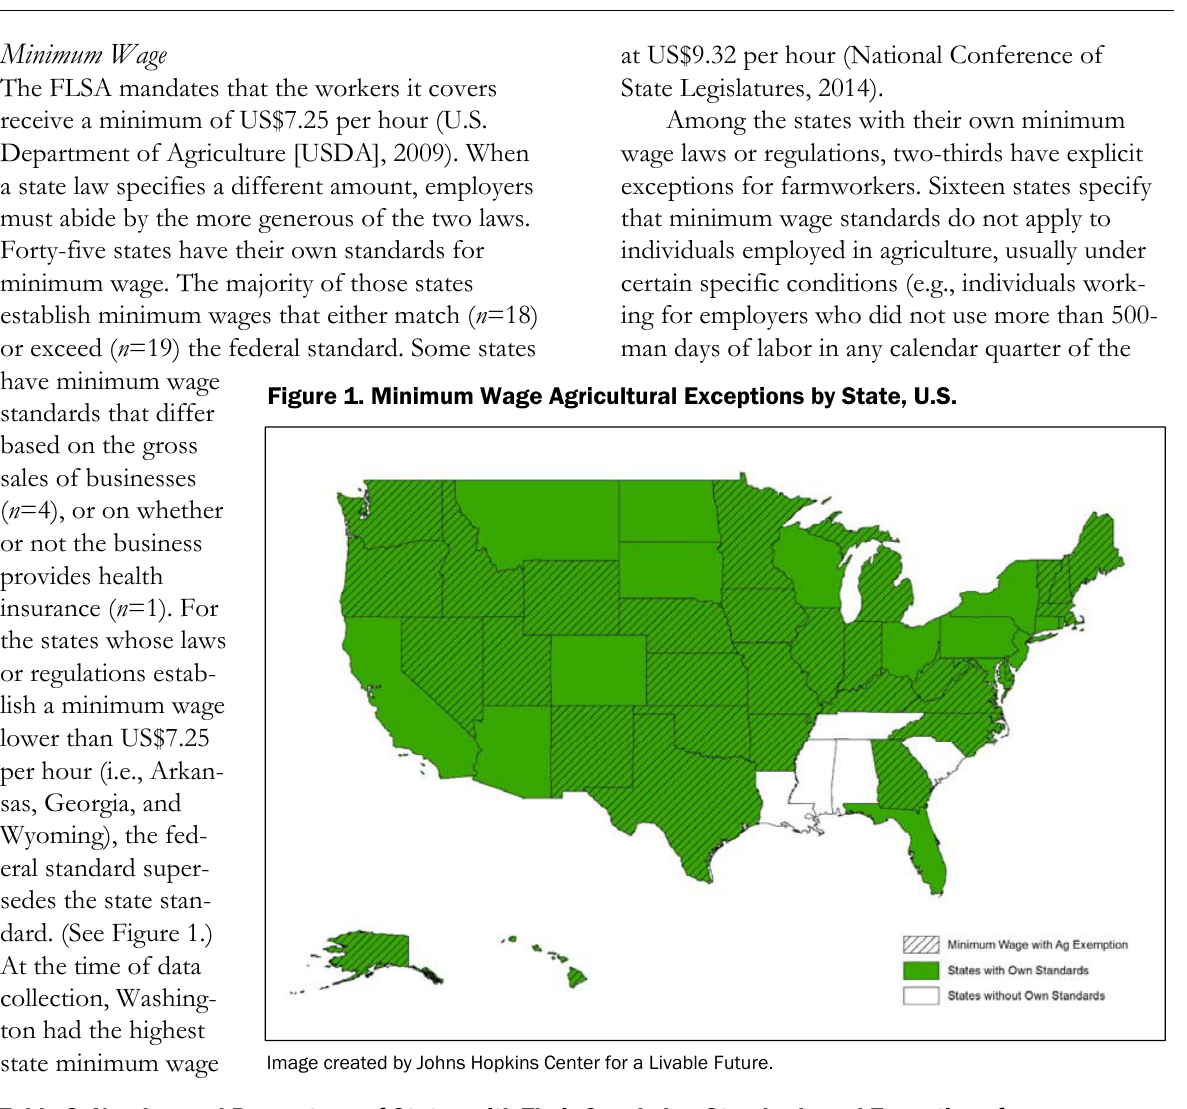
Table 2. Number and Percentage of States with Their Own Labor Standards and Exceptions for Farmworkers